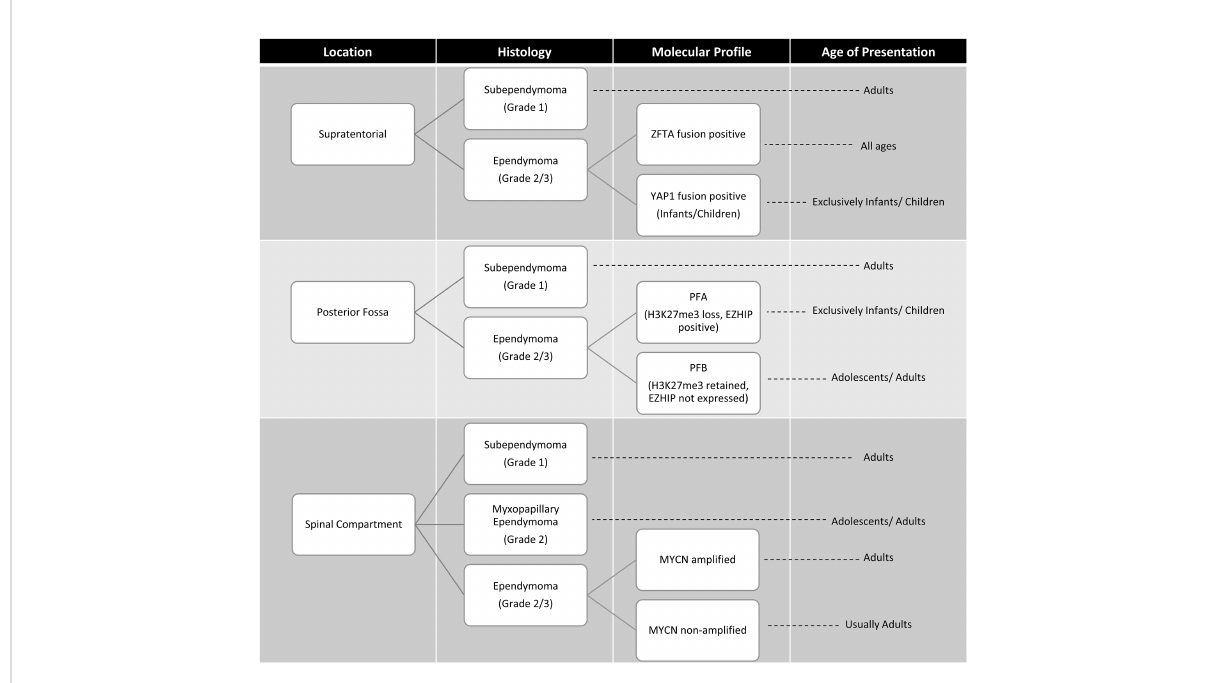
FIGURE 3 Age at presentation and classi fi cation based on anatomic site, histology and molecular features of ependymomas (33, 34). ZFTA, zinc fi nger translocation associated; YAP1, yes-associated protein 1; posterior fossa type A (PFA) and posterior fossa type B (PFB) MYCN, N-myc proto